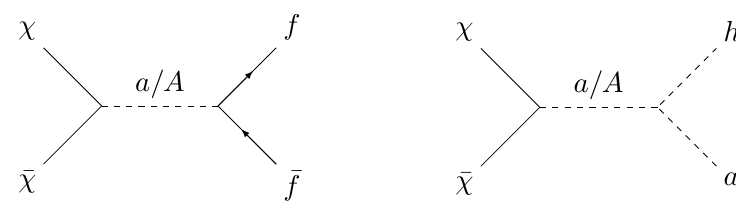
Figure 4 . The dominant annihilation diagrams at the tree-level, where f indicates the SM fermion.